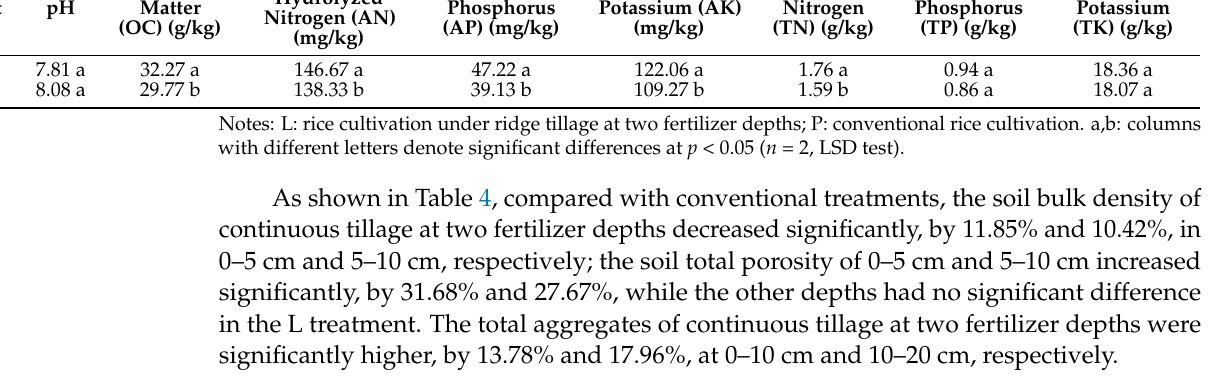
Table 3. Effects of continuous tillage at two fertilizer depths on soil nutrient content.